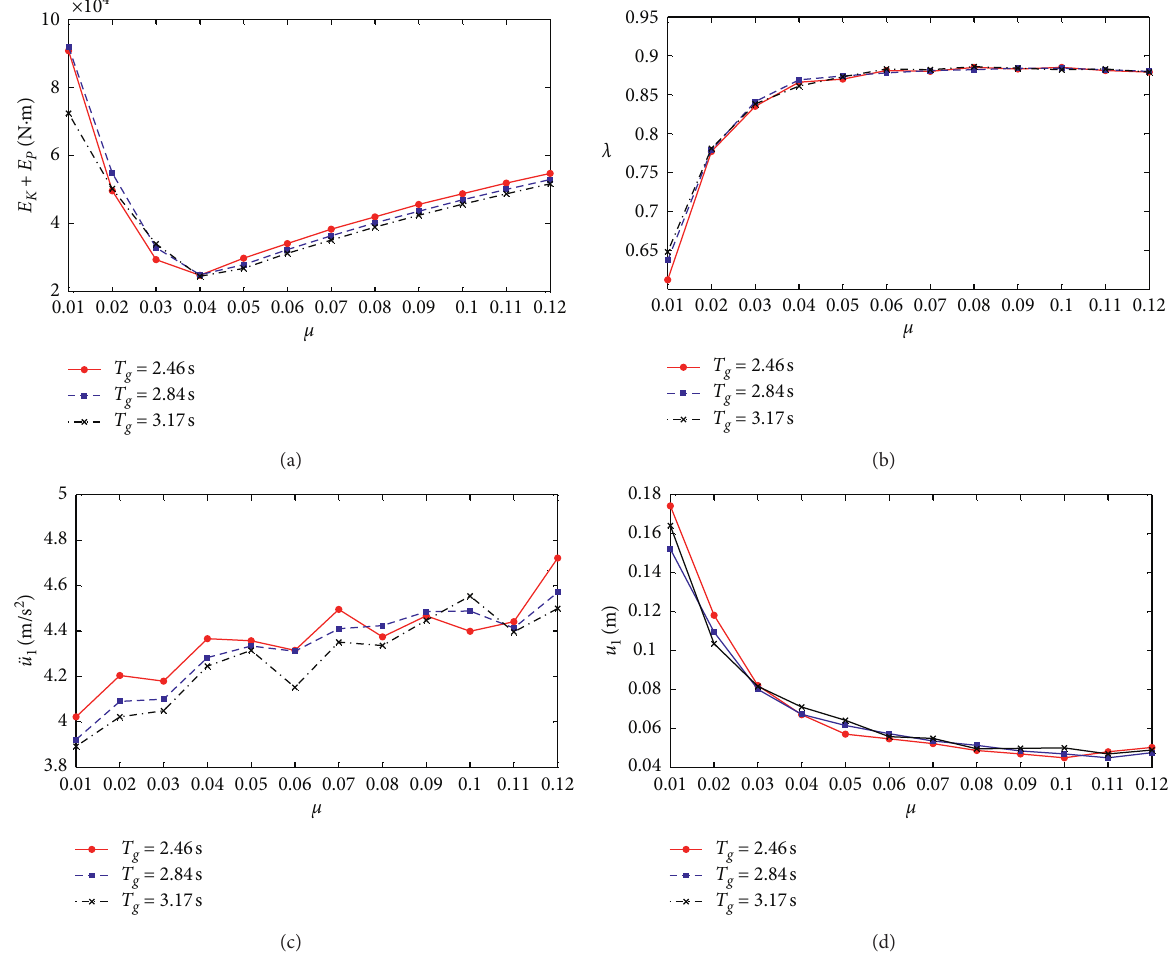
Figure 15: Seismic response amplitude (El Centro, peak acceleration 0.4 g ). (a) Structural response energy; (b) energy consuming ratio; (c) acceleration amplitude of the main beam; (d displacement amplitude of the main